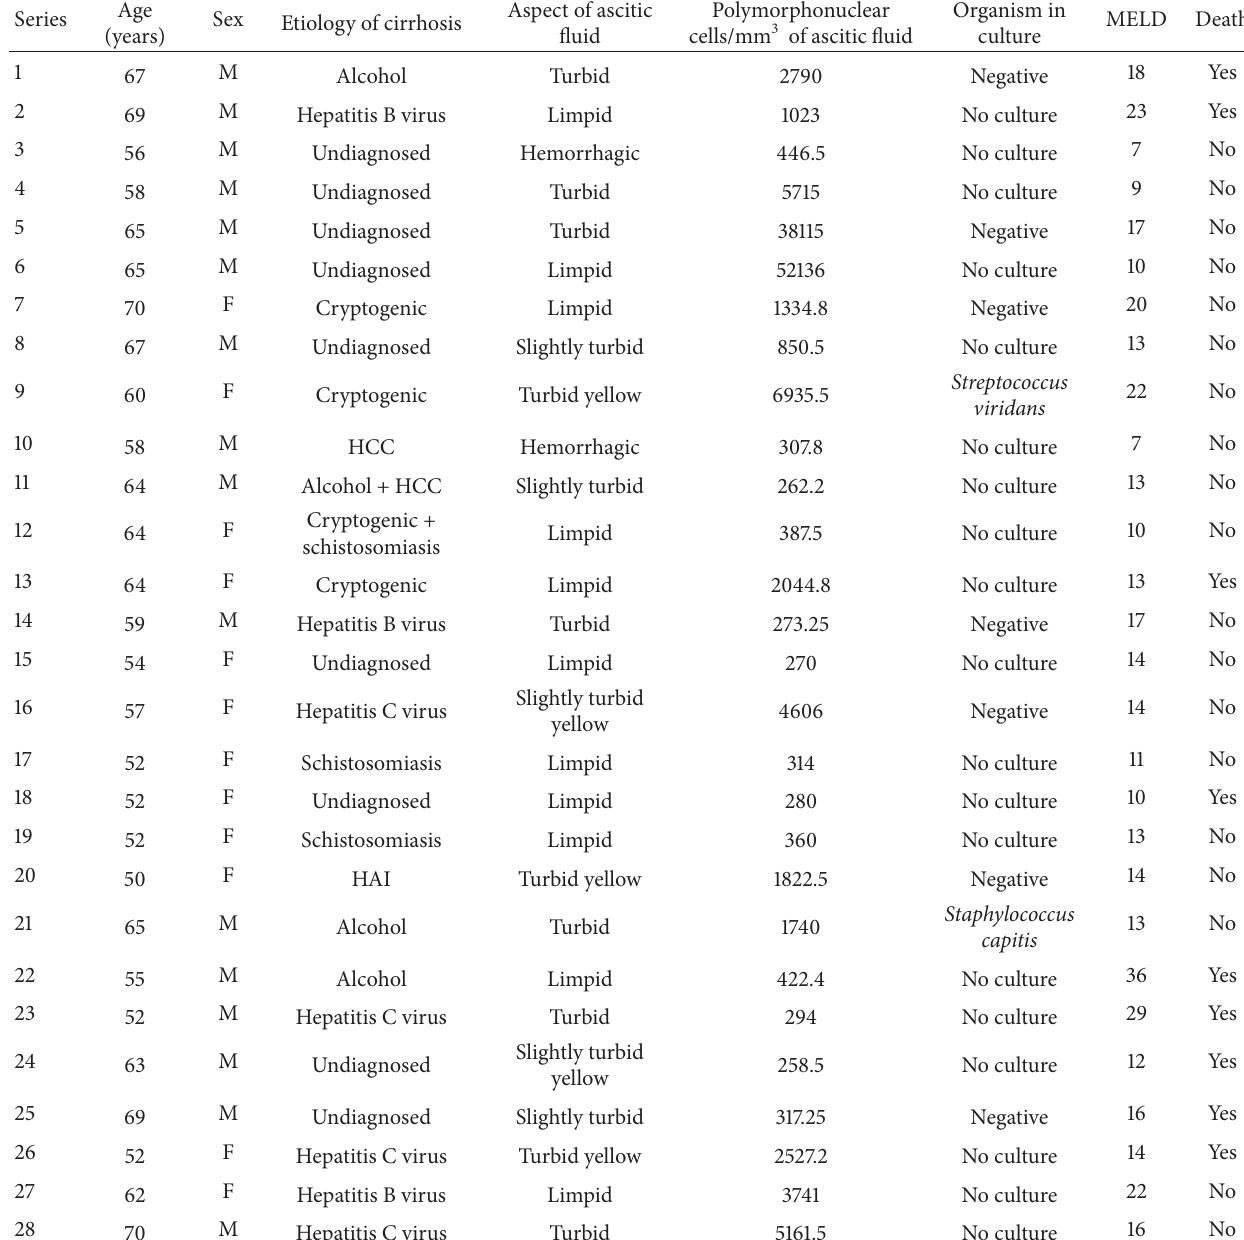
Table 3: Characteristics of patients with spontaneous bacterial peritonitis undergoing large volume paracentesis. Series